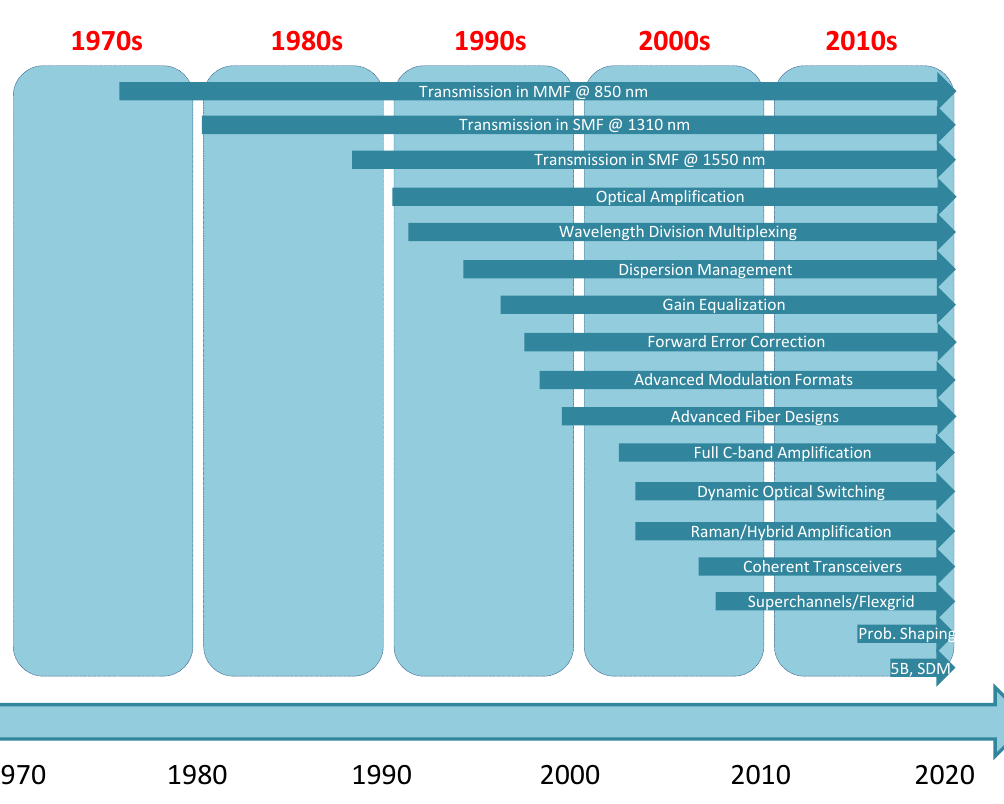
Figure 30. Overview of the key technological advances which allowed to increase the B × L product in optical transmission.